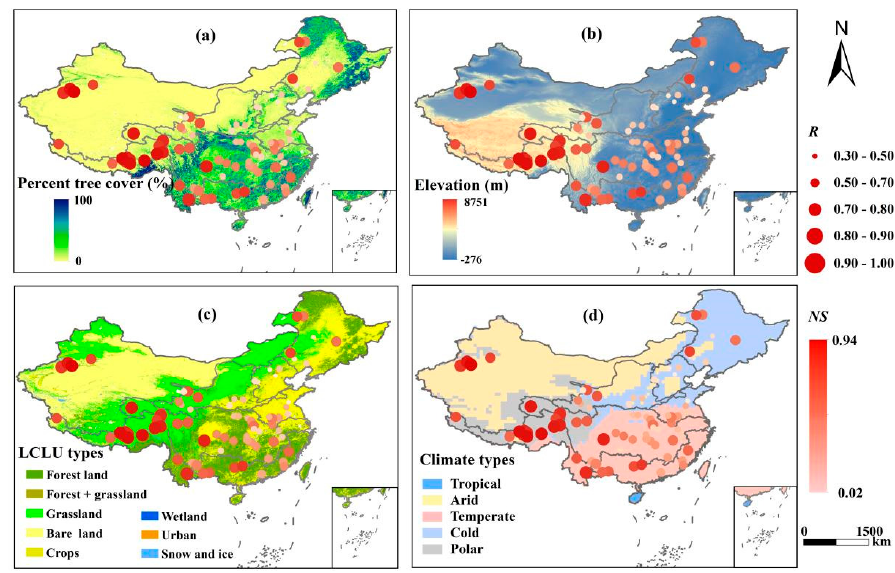
Figure 11. Spatial distribution maps of R and NS : ( a ) percent tree, ( b ) elevation, ( c ) LULC types and ( d ) climate types.